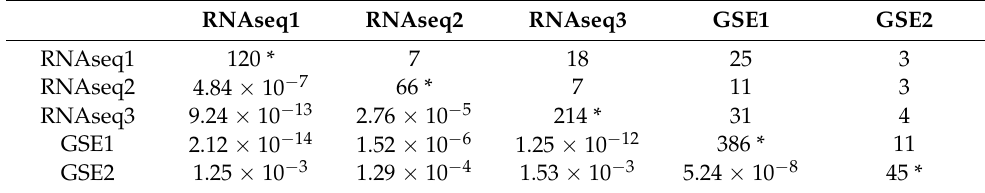
Table 4. Pairwise overlapping of GSNCA-identified pathway hub genes among five datasets. Diag- onal: number of hub genes merged from dataset-specific significant pathways. Cells in the upper triangle denote the numbers of overlapping hub genes. Cells in the lower triangle denote the p -values for the corresponding overlapping quantity that was estimated from the binomial distribution model. RNAseq1 RNAseq2 RNAseq3 GSE1 GSE2 RNAseq1 120 *